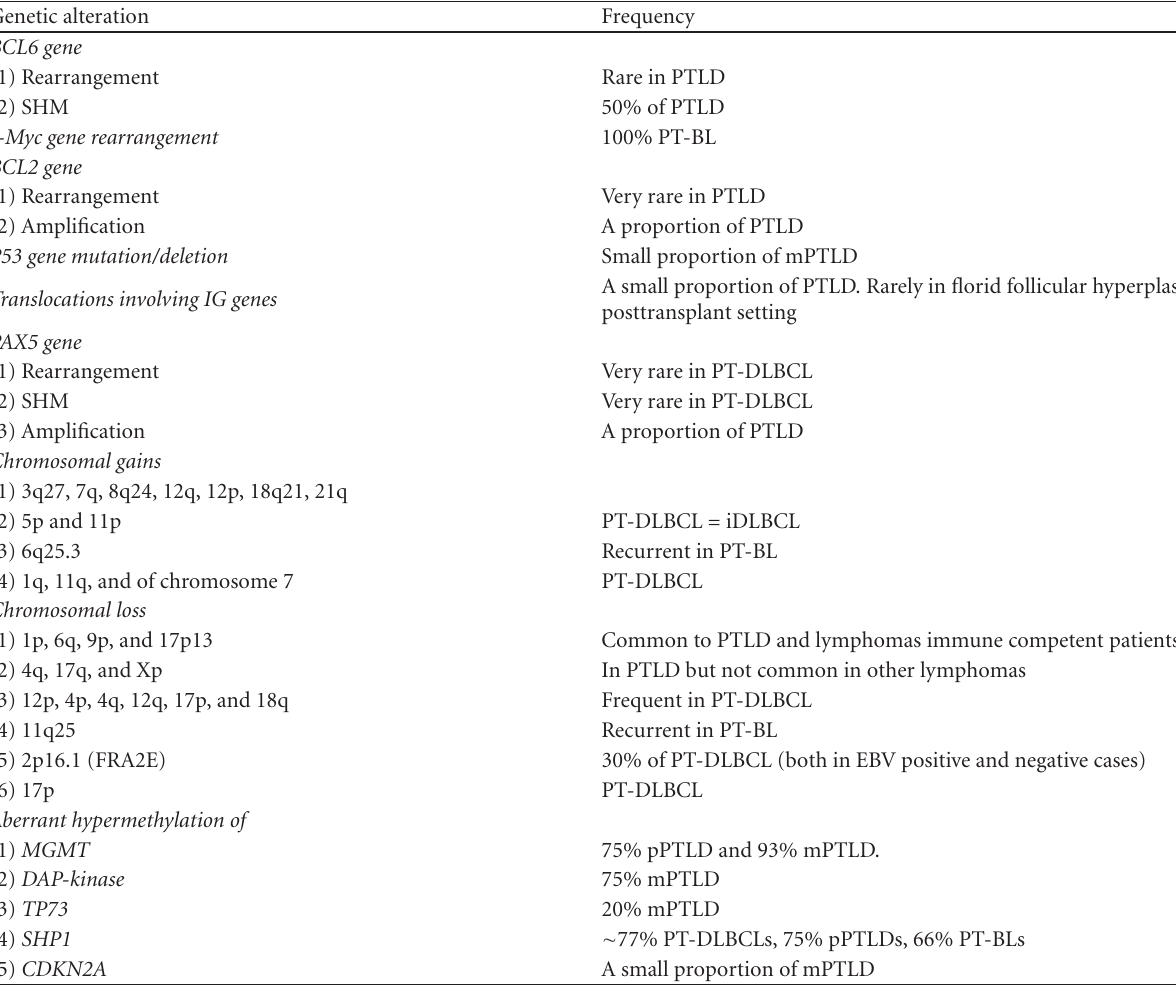
Table 4: Summary of di ff erent genetic alterations among